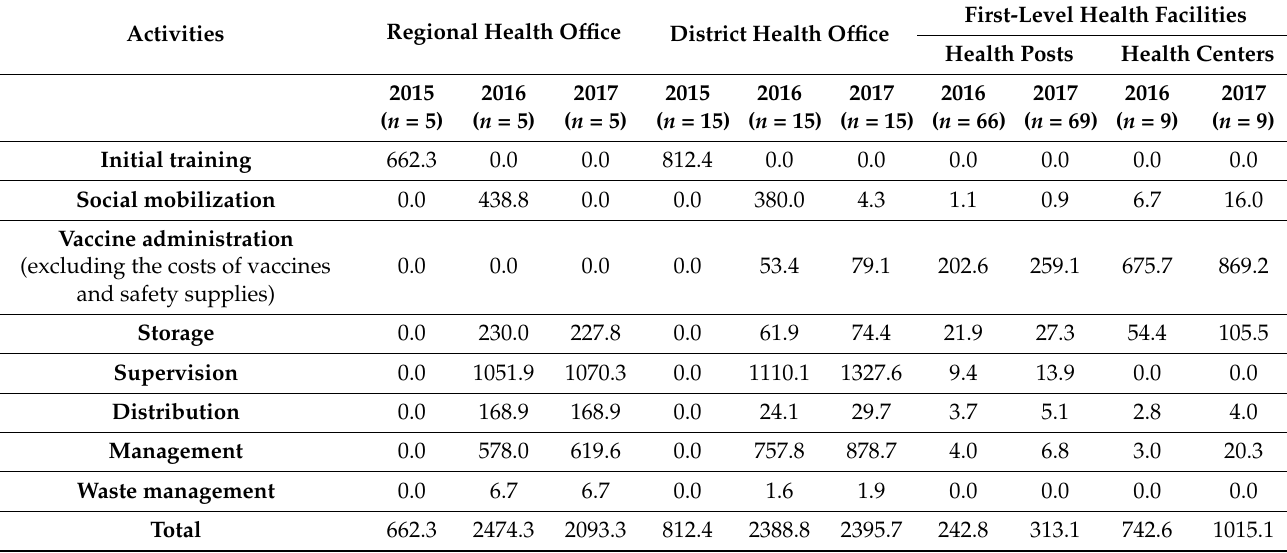
Table 1. Weighted average economic costs (in USD 2016) per activity and per study site in